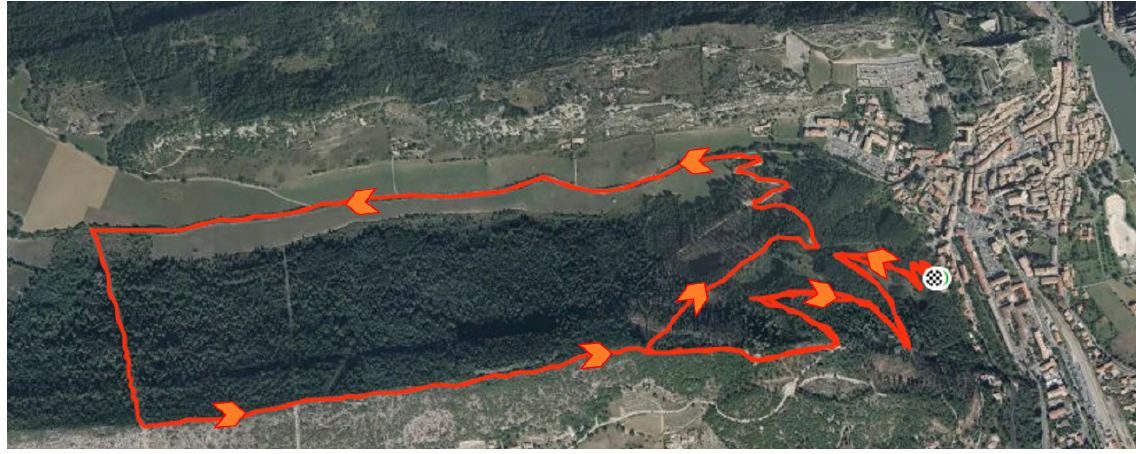
Figure 2. Satellite view of loop.